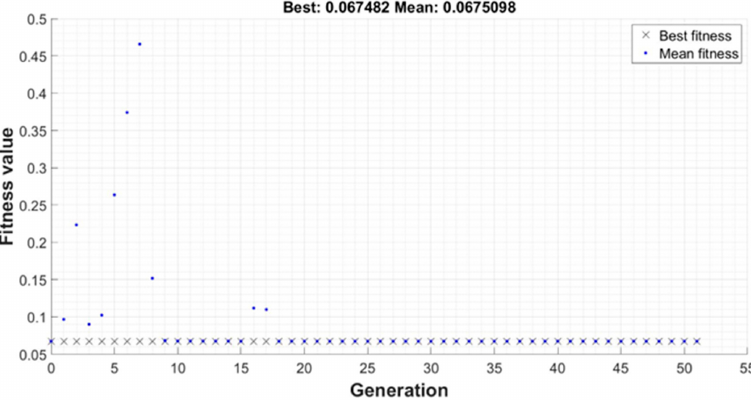
Figure 7 . Optimization evolution of the best value and mean value .